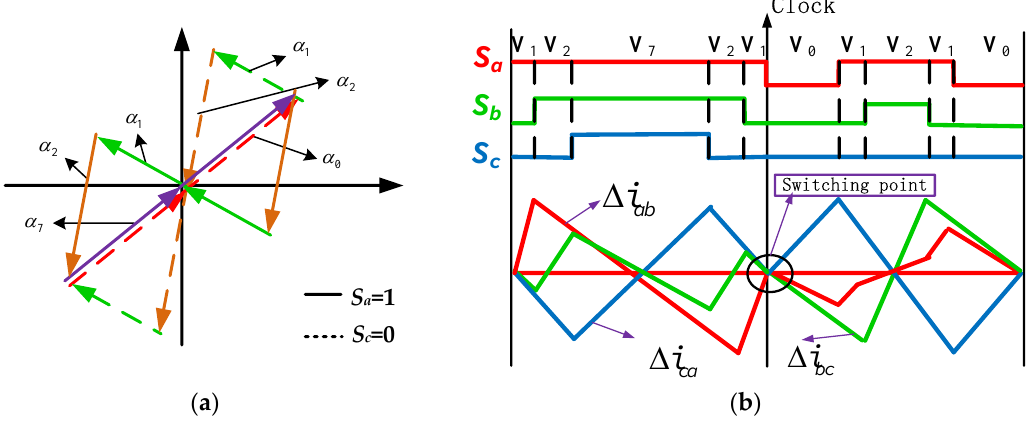
Figure 10. The control mode switching in the zero-crossing point of current errors. ( a ) Current errors changes smoothly (S 01 :solid line; S 11 : dotted line); ( b ) operation of three-phase switches.